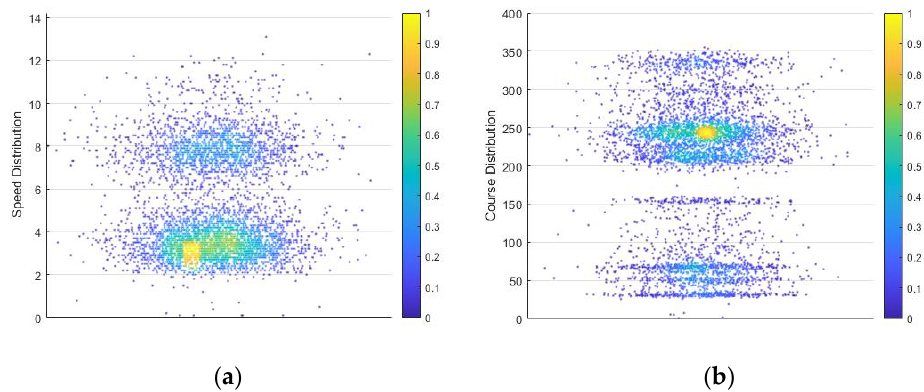
Figure 1. Velocity and course thermodynamic profile. ( a ) Speed; ( b ) course.